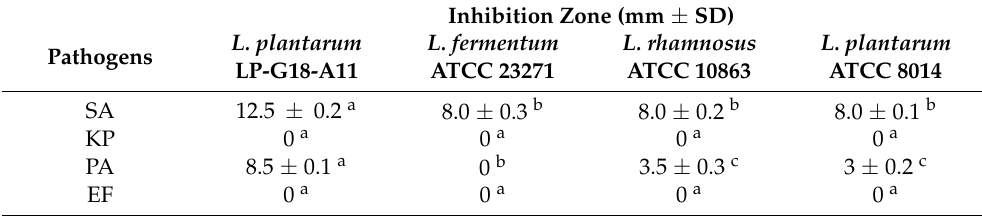
Table 1. Inhibitory activity of lactobacilli strains against pathogenic bacteria.